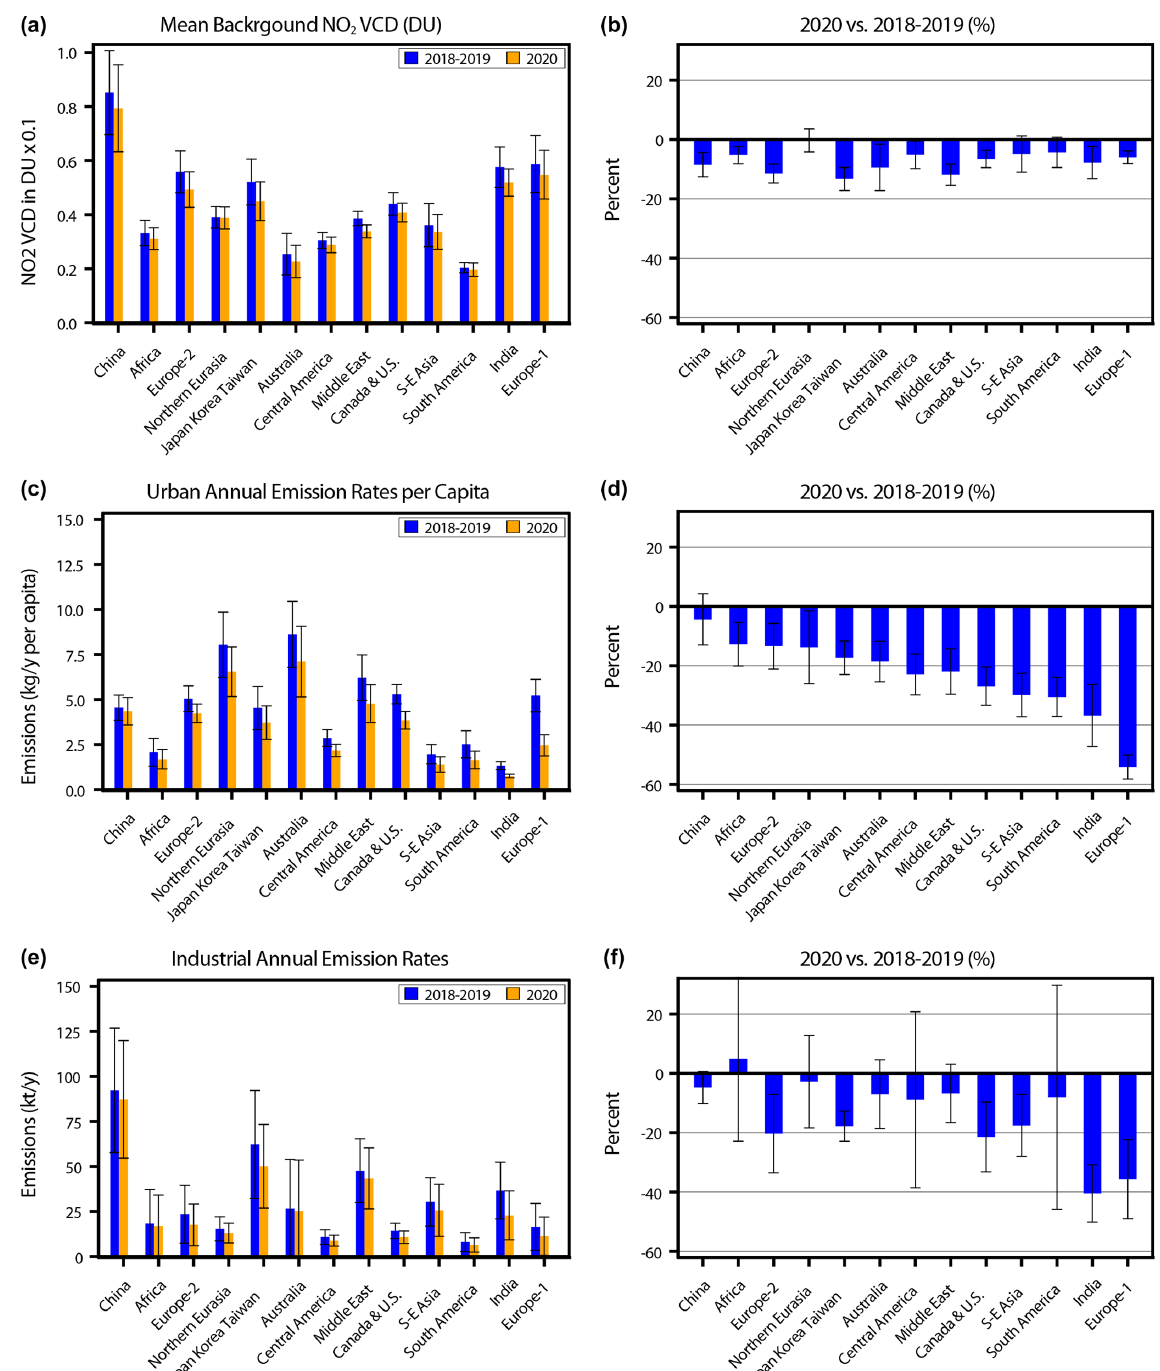
Figure 15. (a, c, e) The mean values for 16 March–15 June in 2018–2019 (blue) and 2020 (orange) values for (a, b) the background, (c, d) urban, and (e, f) industrial components for the 13 regions. (b, d, f) The decline in 2020 mean values in percent from the mean 2018– 2019 values. The data are sorted according to the changes between 2020 and 2018–2019 in the urban component (d) . Mean values for each region were calculated as a mean of the values from all areas for that region. The uncertainty ( σ ) was calculated as a standard error of the mean. The error bars represent 2 σ